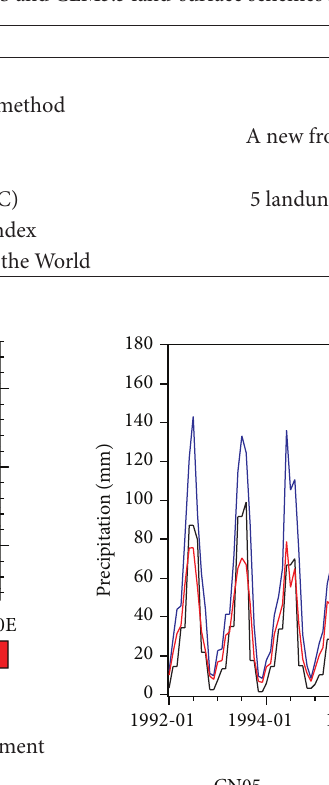
Table 1: Comparisons of the BATS and CLM3.5 land-surface schemes in RegCM4.